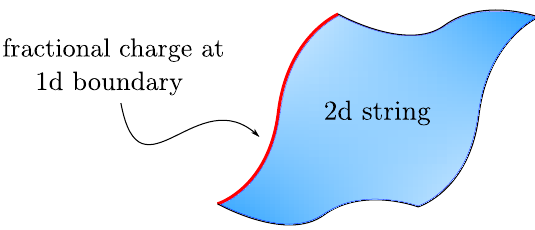
Figure 10 . In the theory T [ S 1 , P ] given by a mixed polarization P , there are strings whose boundaries carry a “fractional charge” under the 1-form symmetry of the theory. This does not contradict the Dirac quantization condition, which applies only to independent